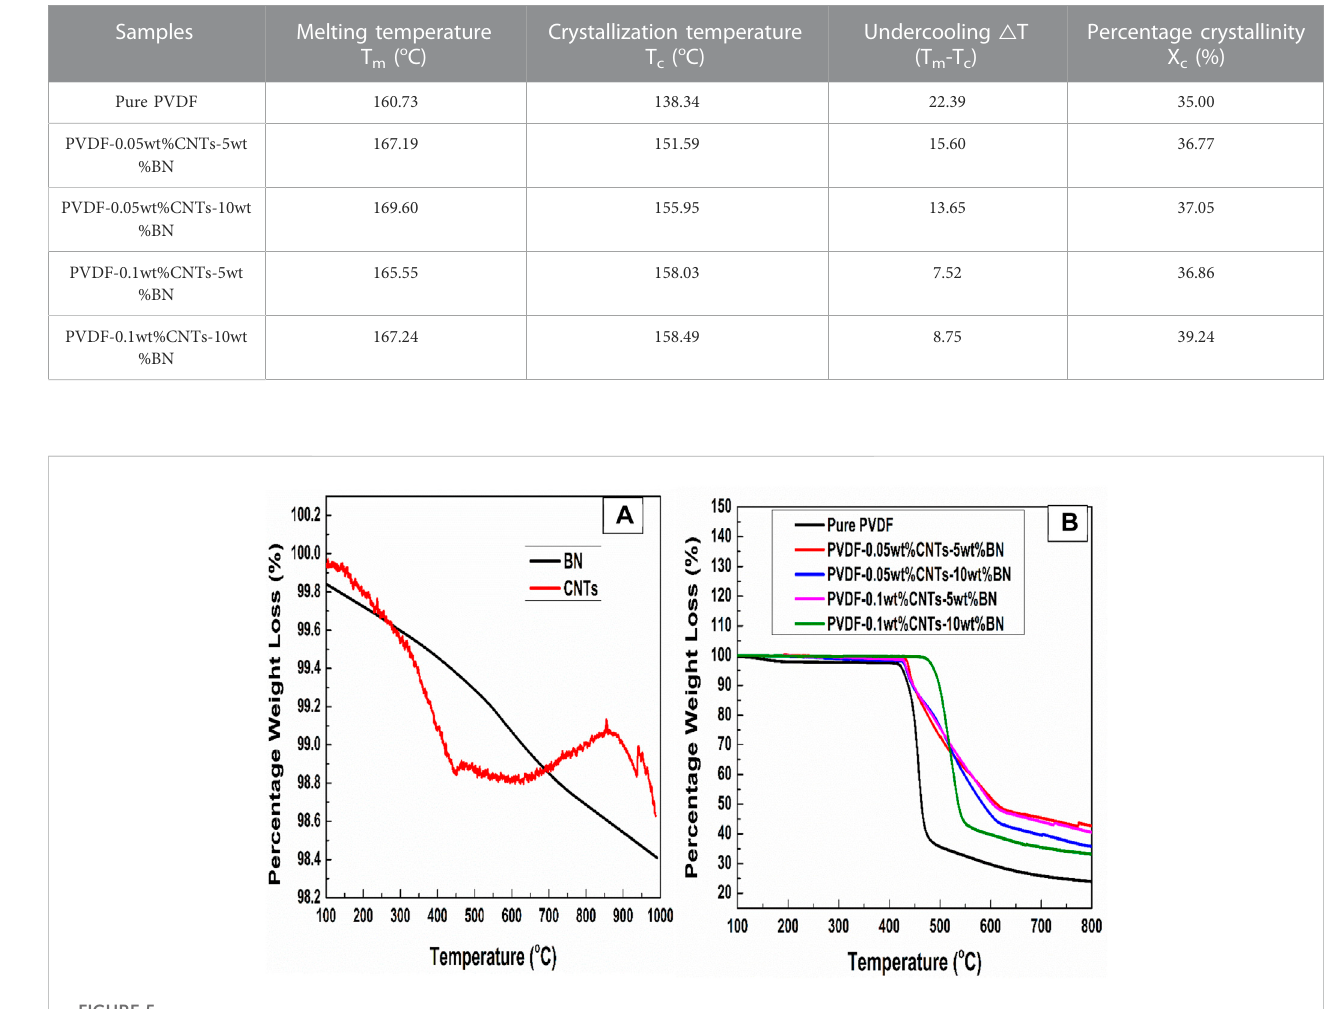
TGA curves of the (A) nanoparticles and (B)